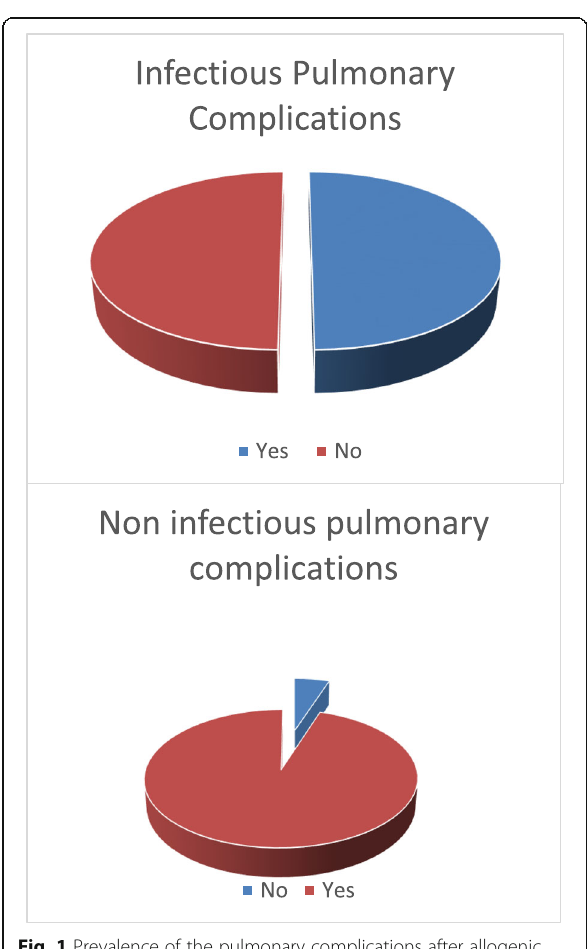
Table 3 Distribution of the studied cases according to radiological signs ( n = 20) Radiology (X ray, CT) ( n = 20 # ) Normal 8 (40%)